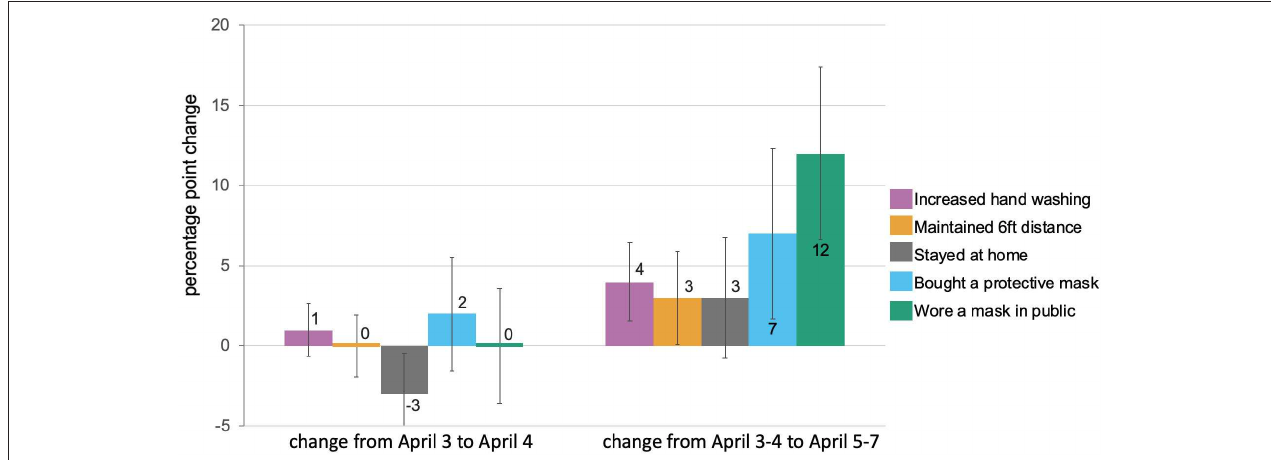
FIGURE 1 | Changes in Americans’ COVID-19 preventive behaviors before and after the CDC recommendation that all Americans wear masks. Error bars represent 95% confidence intervals.